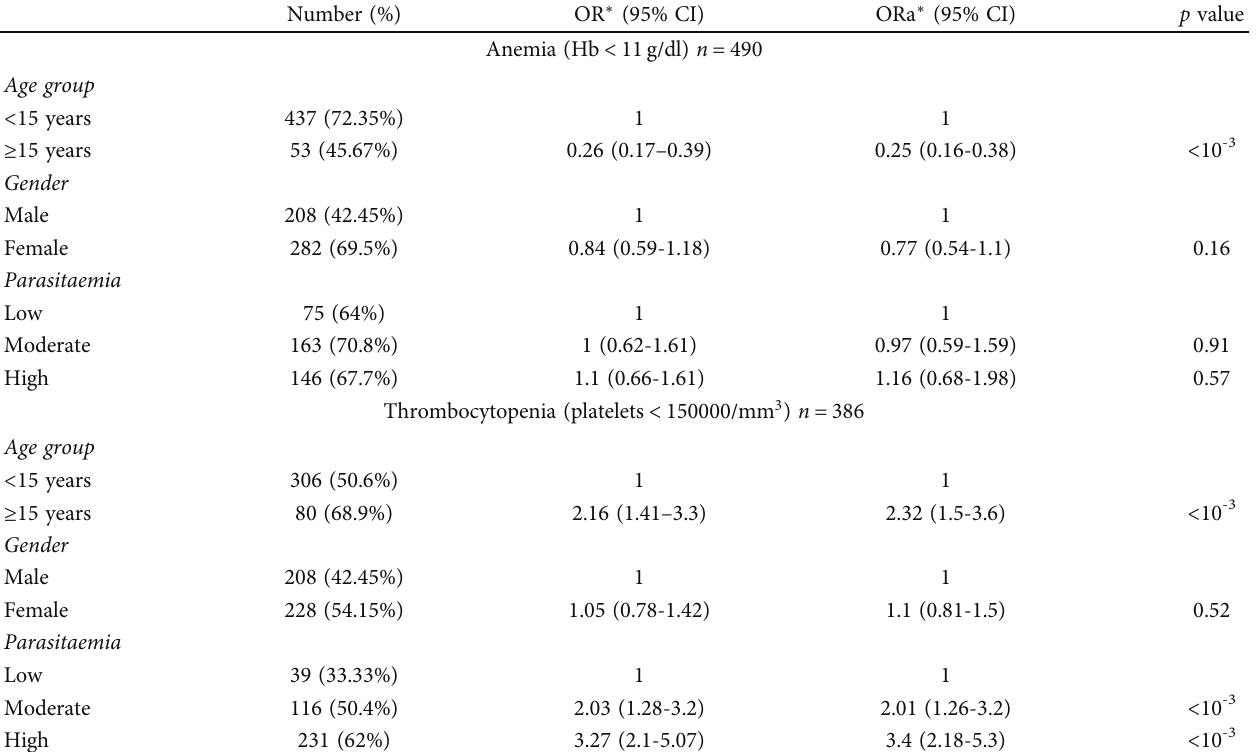
Table 3: Associated factors with anemia and thrombocytopenia at